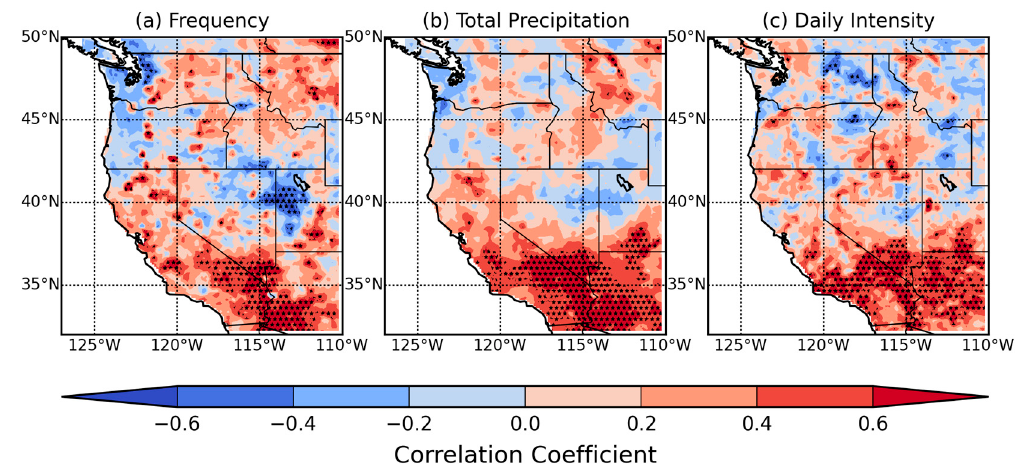
Figure 7. The correlation coefficient between total column water vapor and winter season precipitation ( a ) frequency, ( b ) seasonal total, and ( c ) mean daily intensity over the western United States during winter season from 2003 to 2016. Hatching indicates areas of statistical significance.